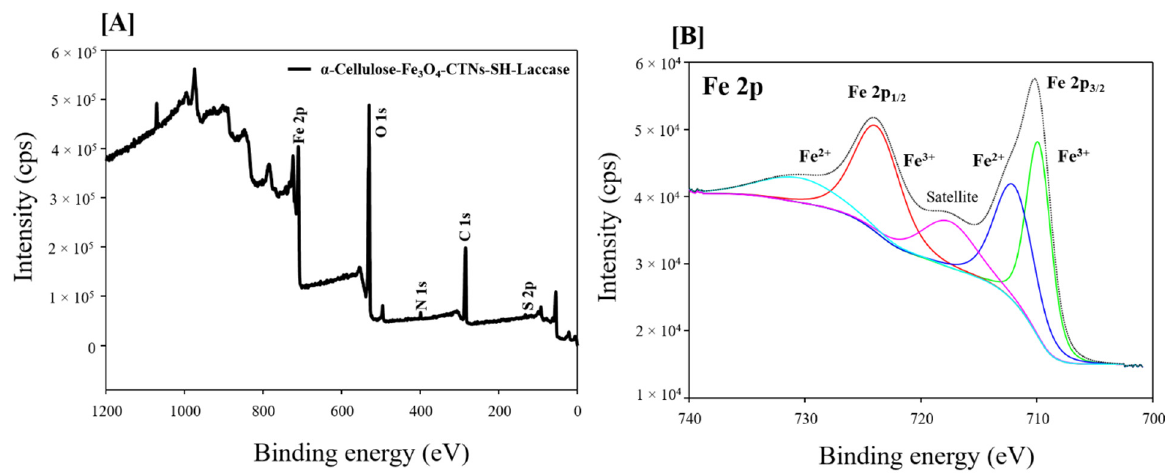
Figure 5. ( A ) XPS analysis of the α -Cellulose-Fe 3 O 4 -CTNs-SH-Laccase, and ( B ) high-resolution Fe 2p XPS spectrum of α -Cellulose-Fe 3 O 4 -CTNs-SH-Laccase.